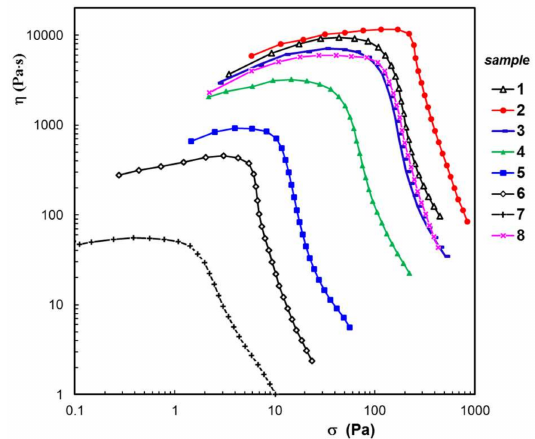
Figure 7. The viscosity as a function of the applied shear stress for the hydrogel samples (37 ◦ C). In the presence of BSA, the rheological parameters of the PULL/PVA matrix registered lower values. In frequency sweep experiments, the viscoelastic moduli, G (cid:48) and G (cid:48)(cid:48) , showed a slight variation with the oscillation frequency ( ω ). The loss tangent values were between 0.08 (samples 1 and 2) and 0.1 (samples 3–8), suggesting that a stable network structure was formed in all cases. The physical strength of the hydrogel (indicated by G (cid:48) and σ y values) slightly decreased with the increased BSA content (samples 2 to